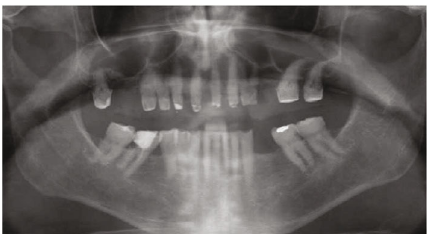
Figure 9: The panoramic radiograph with the interim restoration showing that the dental pulp was not involved after the prosthetic procedure.